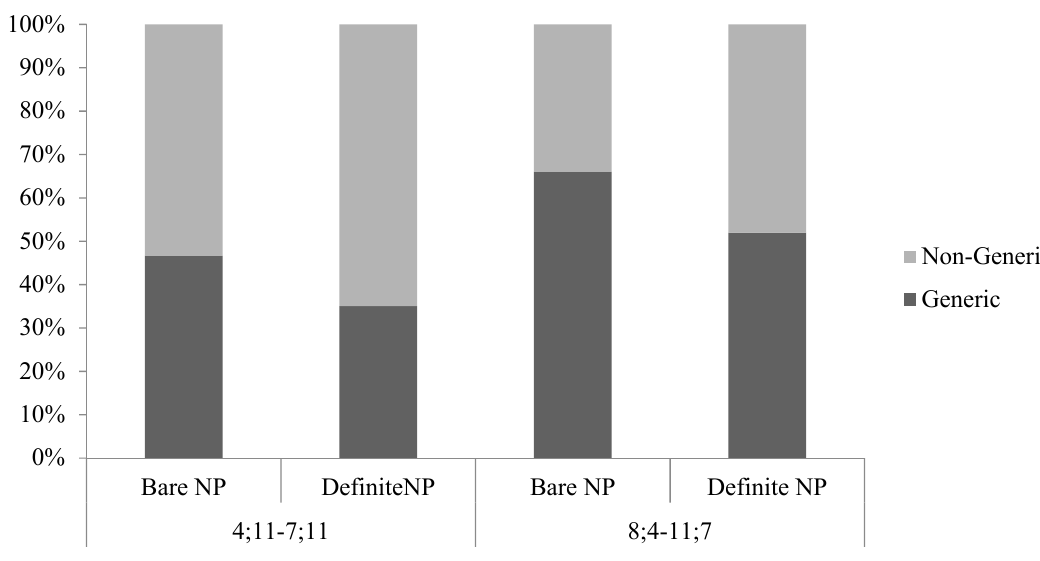
Figure 3. Interpretation of definite and bare plural NPs, according to the learner’s age.